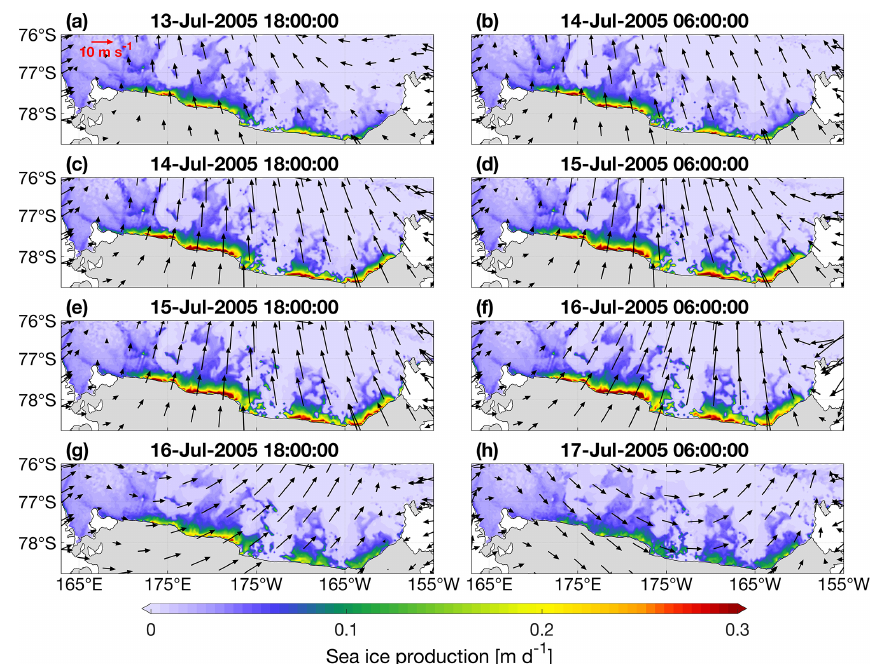
Figure 5. (a–h) Spatial distributions of 12h average wind vectors and sea ice production (colored shading) in the Ross Ice Shelf Polynya over 13–17 July